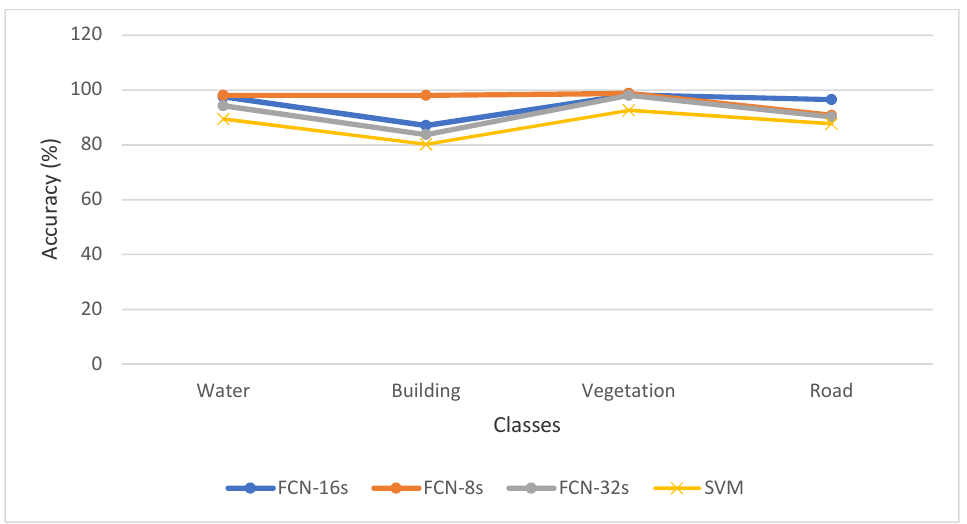
Figure 6. Accuracy analysis for each of the individual classes.